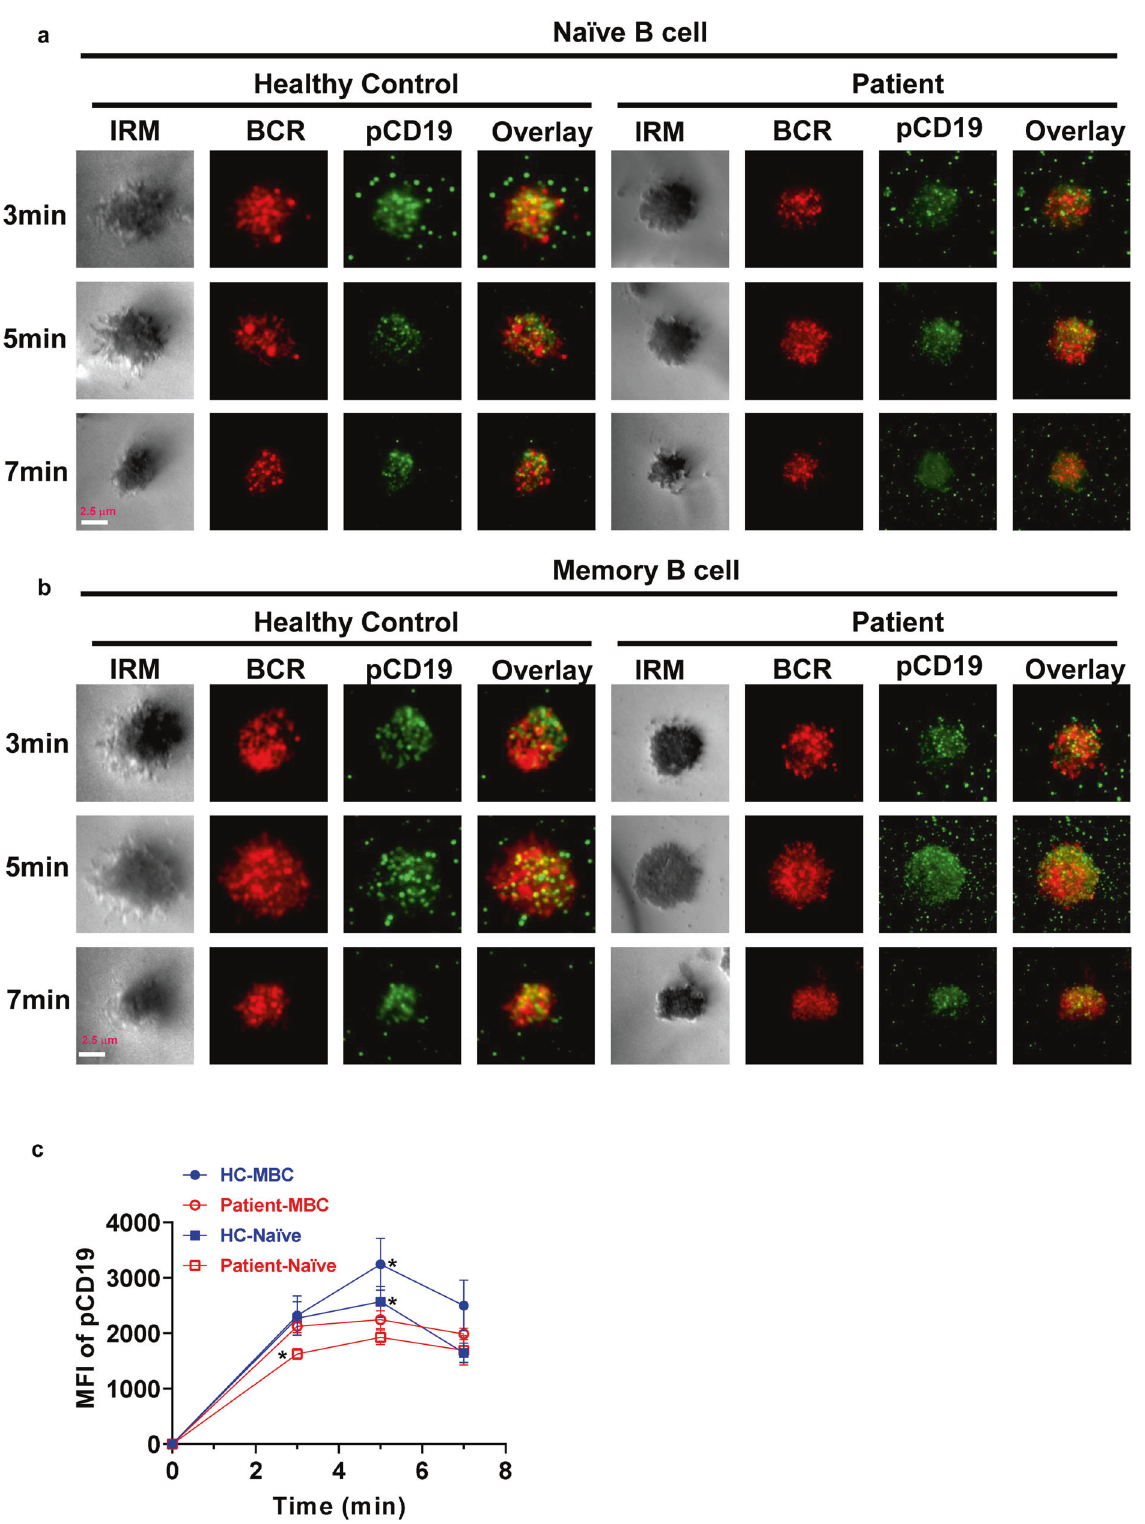
Fig. 6 SARS-CoV-2 infection inhibits the early activation of CD19 in B cells. Naive (CD27 − ) and memory (CD27 + ) B cells from COVID-19 recovered patients and healthy controls were activated with 10 µg/ml AF546 – mB-Fab ′ – anti-Ig tethered to lipid bilayers at 37 °C for 3, 5 and 7 min. Then cells were fi xed, permeabilized, and stained with Alexa Fluor 647 anti-CD27 and anti-pCD19 ( a , b ), followed by Alexa Fluor 488 goat anti-rabbit IgG. Cells were analyzed by Tirf microscope. Shown are representative images and the MFI of pCD19 ( c ) in the contact zone from three independent experiments. Scale bars, 2.5 μ m. Statistical evaluation was performed using the two-tailed Student ’ s t -test. Statistical signi fi cance is indicated using asterisks: * p < 0.05, ** p < 0.01, *** p < 0.001, and **** p <